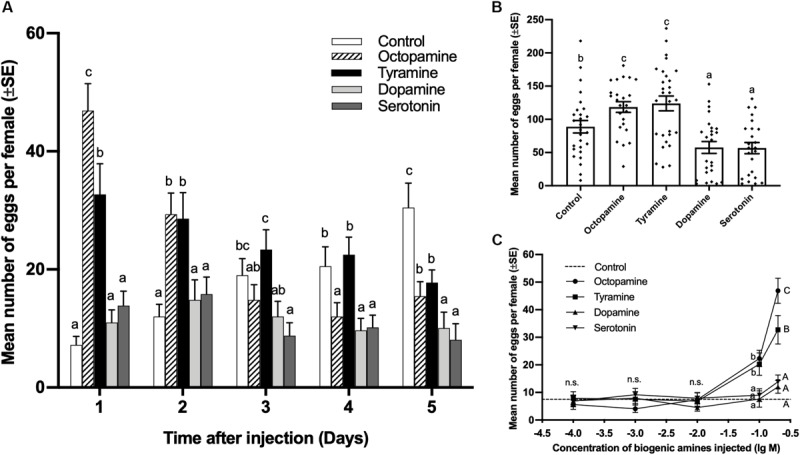
Effect of biogenic amine injections on oviposition by virgin females of Plutella xylostella. Number of eggs laid by females from days 1–5 (A), and total number of eggs laid by females in 5 days (B) after injection with 0.3 μL of 0.2 mol/L octopamine (n = 24), tyramine (n = 30), dopamine (n = 25), serotonin (n = 24), and Milli-Q water as a control (n = 27). Individual data is displayed with dots. (C) Dose-response study of the effects of biogenic amines on the number of eggs laid by virgin females within 24 h after injection (24 ≤ n ≤ 32). Different letters on the top of bars indicate significant differences between treatments on the same day (p < 0.05, ANOVA, Duncan). The dotted line in (C) indicates the number of eggs laid by virgin females injected with Milli-Q water.